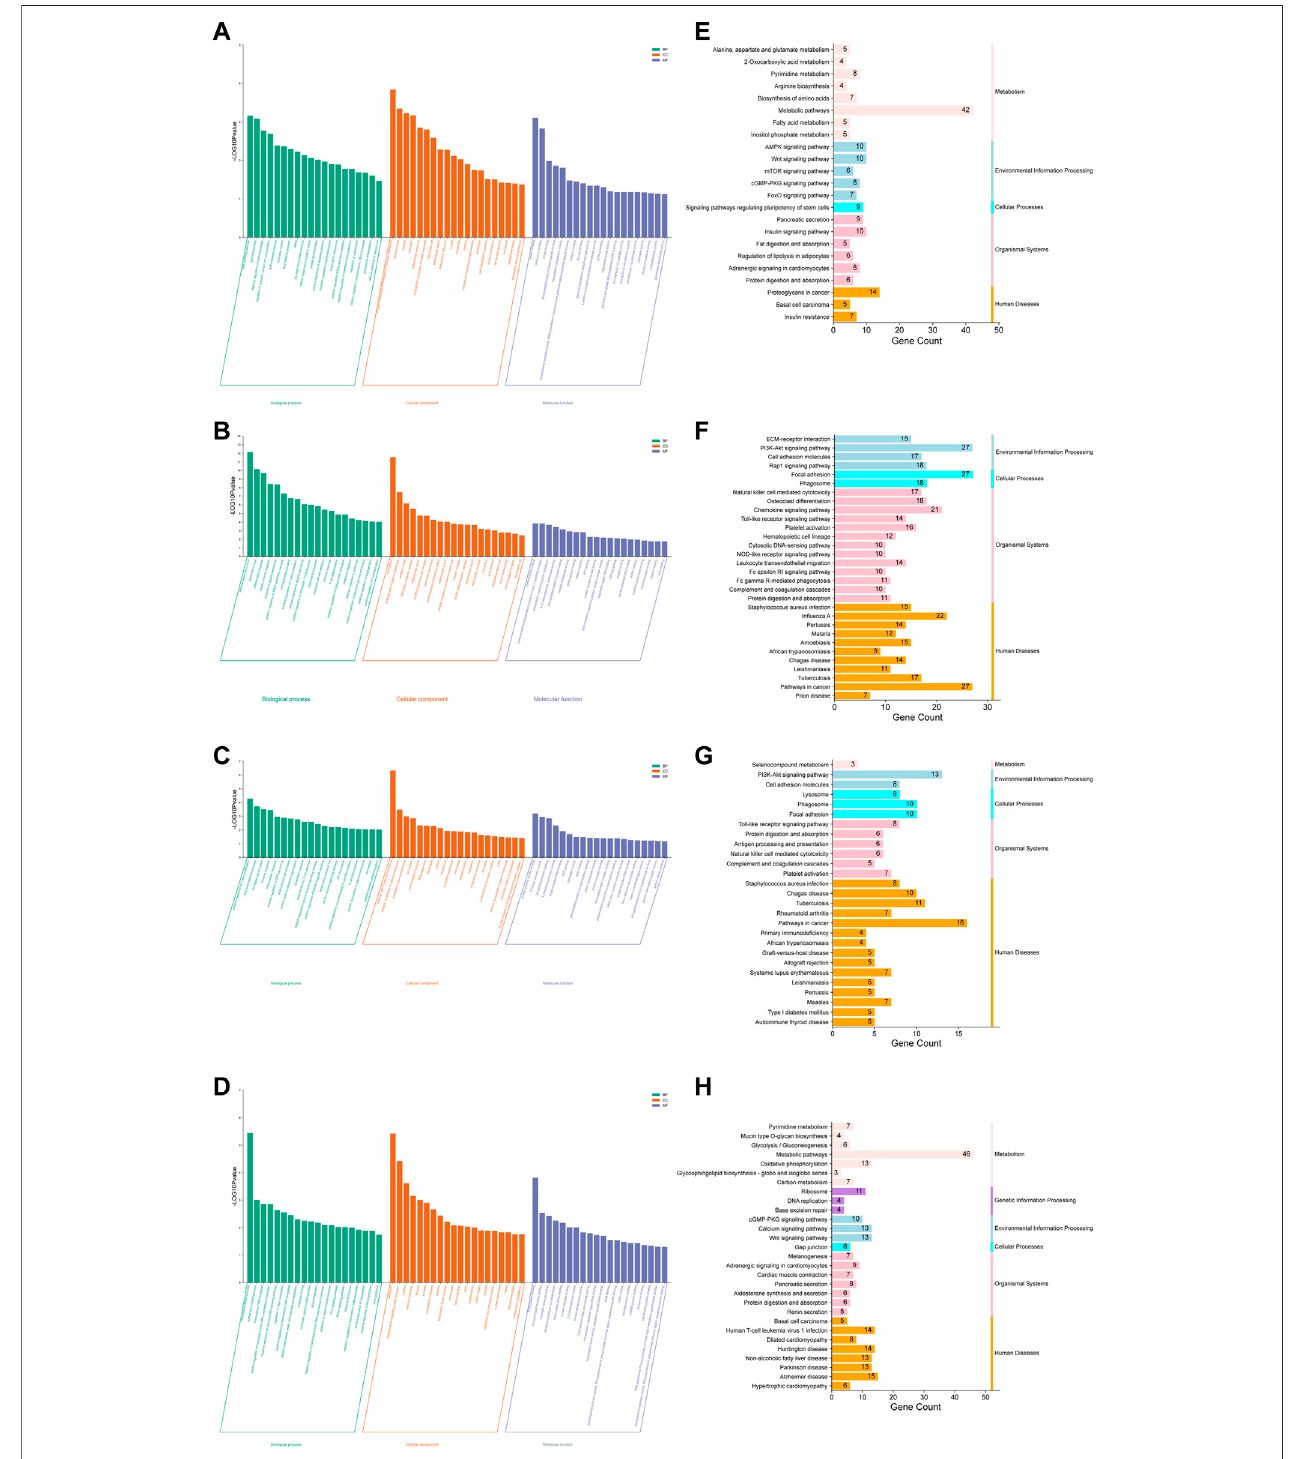
FIGURE 5 | Potential antidiabetic pathways of RR were enriched by the GO and KEGG analyses. (A – D) Histogram of GO enrichment analysis: (A) the normal vs . model group (up); (B) the normal vs . model group (down); (C) the model vs . RRE group (up); (D) the model vs . RRE group (down). The abscissa represents the different GO terms belonging to the three categories, namely, biological process, cellular component, and molecular function. The ordinate represents the logarithmized p value (the enrichment result with the 20 minimum p values are displayed). (E – H) Histogram of KEGG enrichment analysis: (E) the normal vs . model group (up); (F) the normal vs . model group (down); (G) the model vs . RRE group (up); (H) the model vs . RRE group (down). The abscissa represents a number of genes enriched in this pathway. The left ordinate represents the KEGG pathways, the right ordinate represents the categories of the pathways.